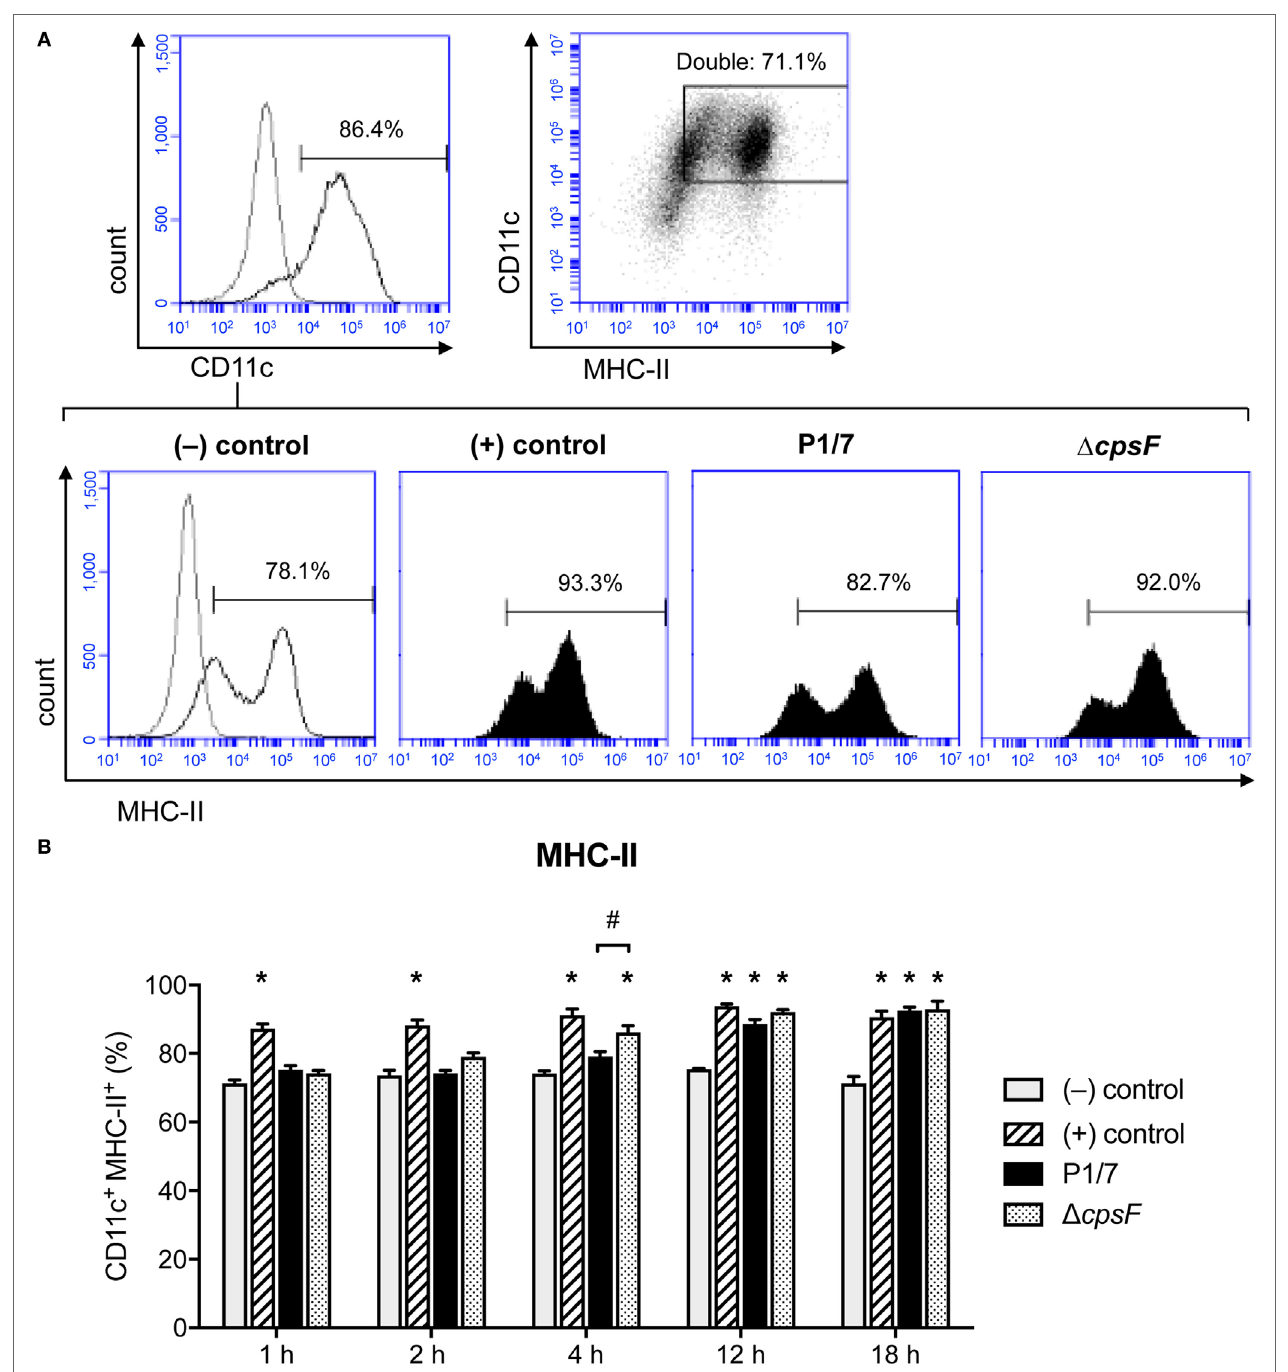
FigUre 1 | Bone marrow-derived dendritic cells (BmDCs) enhance their MHC-II cell surface expression with a delayed kinetics upon stimulation with Streptococcus suis wild-type (WT) strain. Cells were stimulated for 1, 2, 4, 12, or 18 h with S. suis WT strain P1/7 or the non-encapsulated mutant Δ cpsF (initial MOI:1) in technical duplicates. Unstimulated cells served as negative ( − ) control for basal expression at each time point. Cells stimulated with LPS (1 µg/ml) were used as positive ( + ) control. Cells were harvested and fixed after each incubation time. Once the last incubation time was over, cells were surface stained for CD11c and MHC-II and analyzed by FACS. Events are gated on CD11c + cells. (a) Representative histograms have been selected for this figure (at time = 4 h). The gray lines are isotype controls. At least 30,000 gated events were acquired per sample and data analysis was performed using BD Accuri ™ C6 software. Quadrants were drawn based on PE/Cy5- and PE-control stains and plotted on logarithmic scales, a representative dot plot is displayed. (B) Data are expressed as mean ± SEM (% of positive cells) and are from three independent experiments. *P < 0.05 indicates a statistically significant difference compared to ( − ) control cells. # P < 0.05 indicates a statistically significant difference between P1/7-stimulated bmDCs and Δ cpsF -stimulated